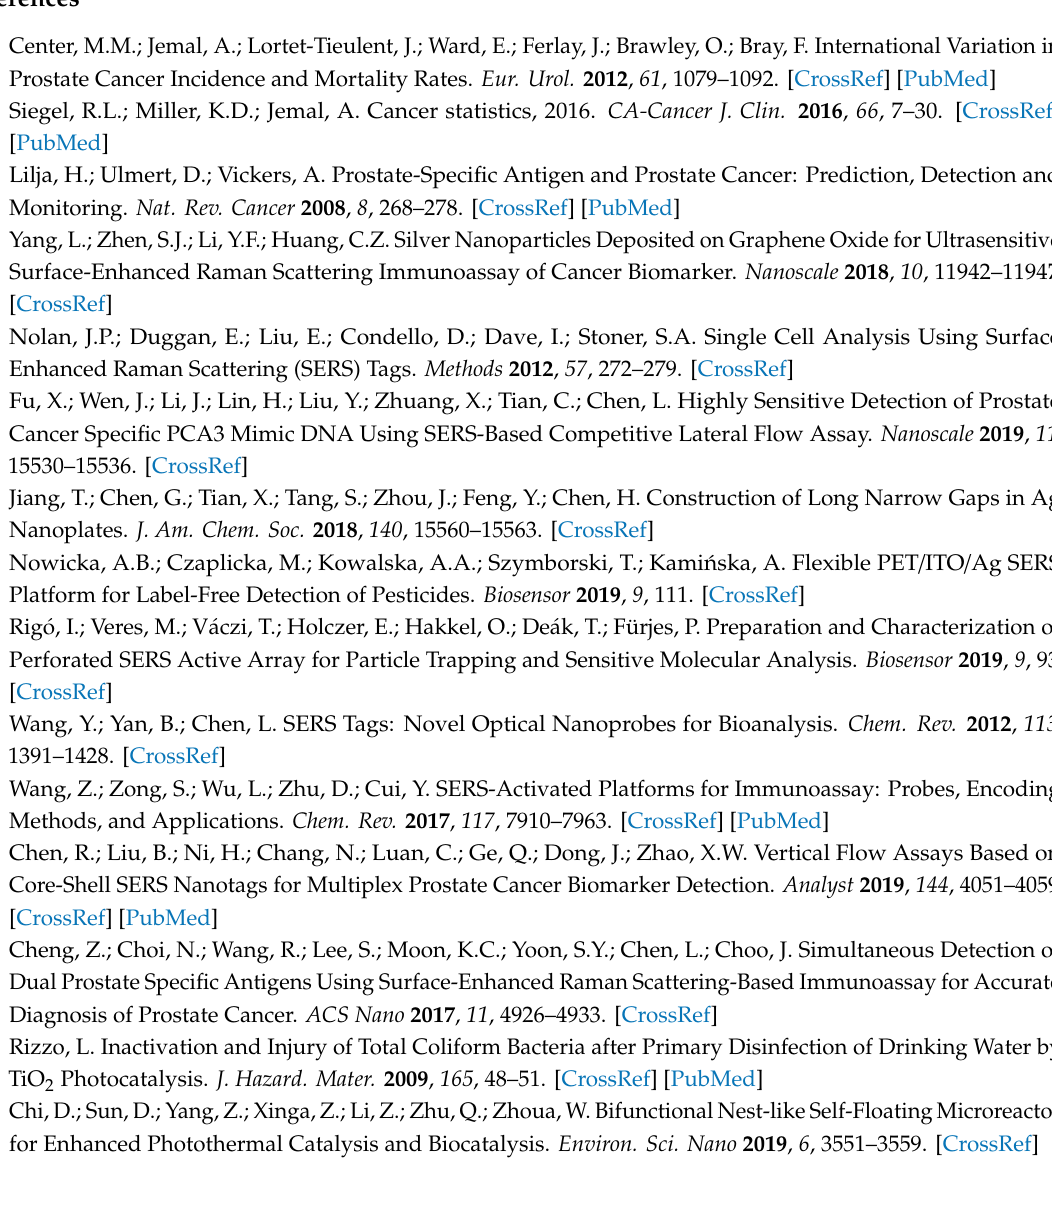
Figure S1: (a) SERS spectral change of 4MBA on the Fe 3 O 4 @TiO 2 @Au NPs synthesized with (a) 20; (b) 40; (c) 60; and (d) 200 mL Au NPs during UV light irradiation, Figure S2: SEM images of (a) blank sandpaper and